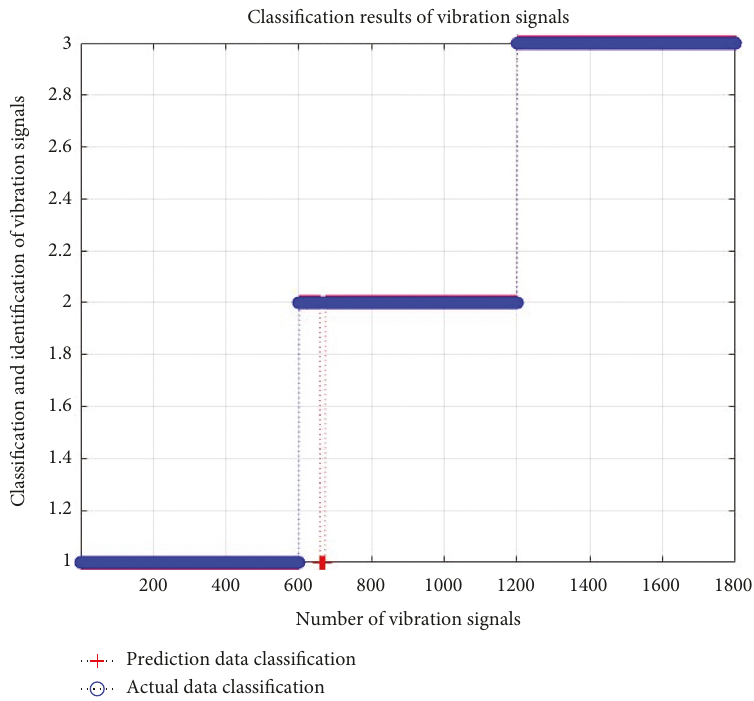
Figure 14: Identification rate of the inlet based on MRFO-BP neural network.